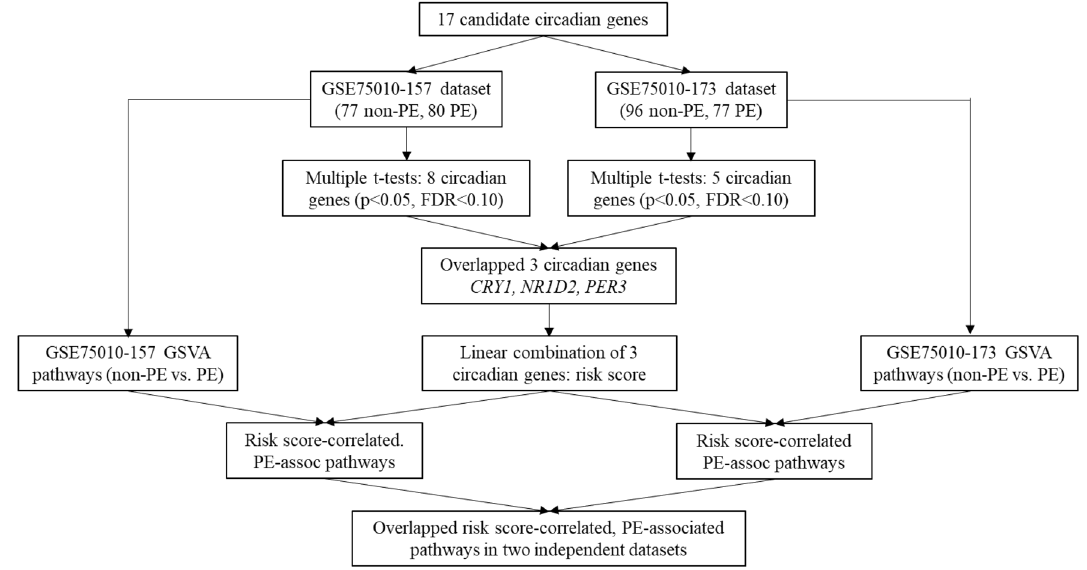
Figure 1. Bioinformatics pipeline to analyze circadian genes-correlated, PE-associated